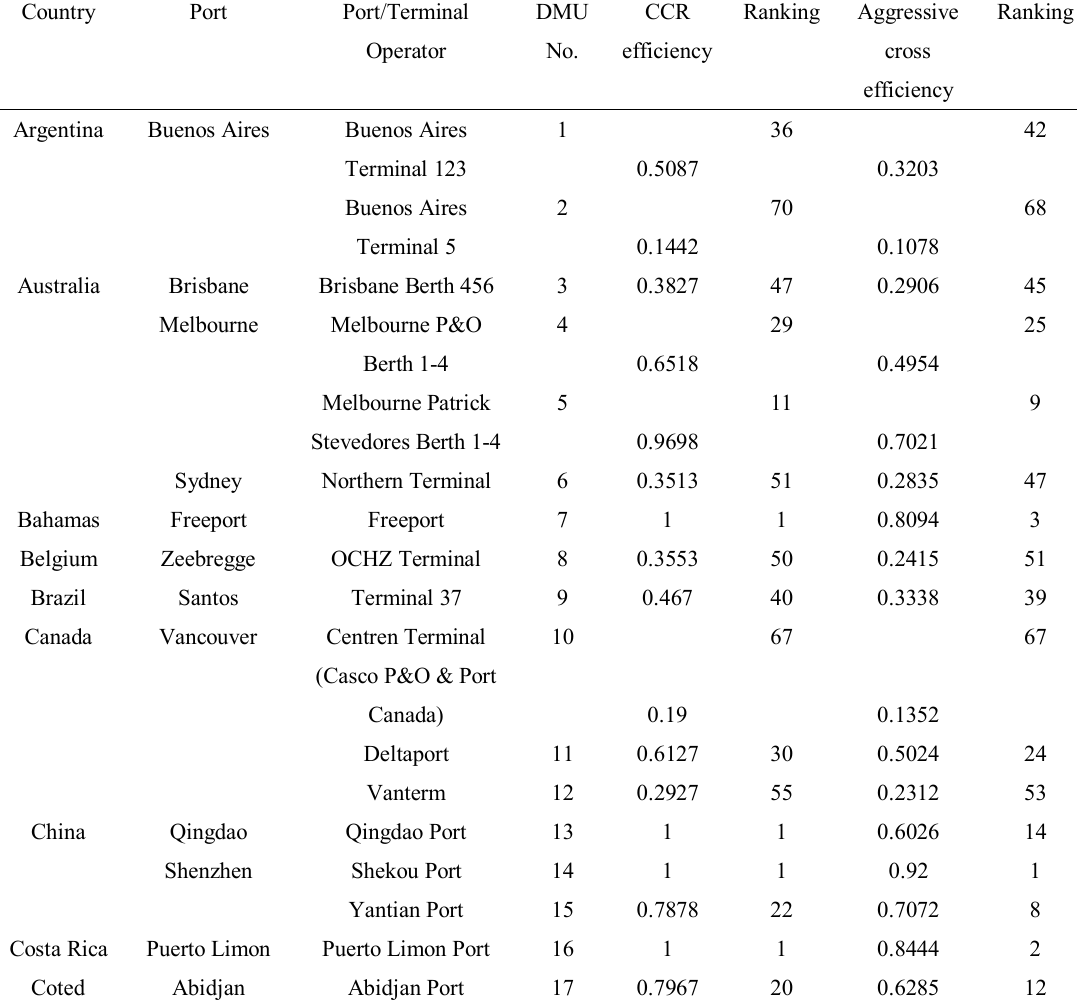
Table 4. Performance evaluation results of container